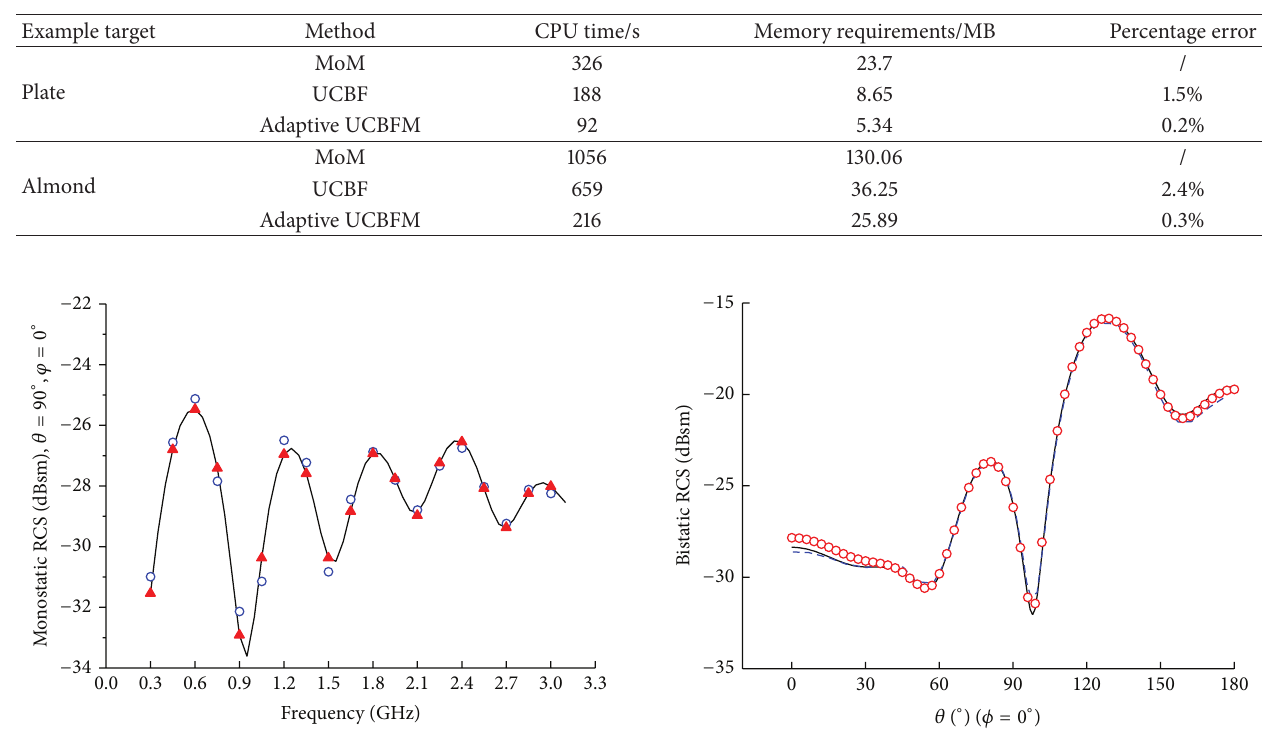
Table 3: CPU time and memory requirements.